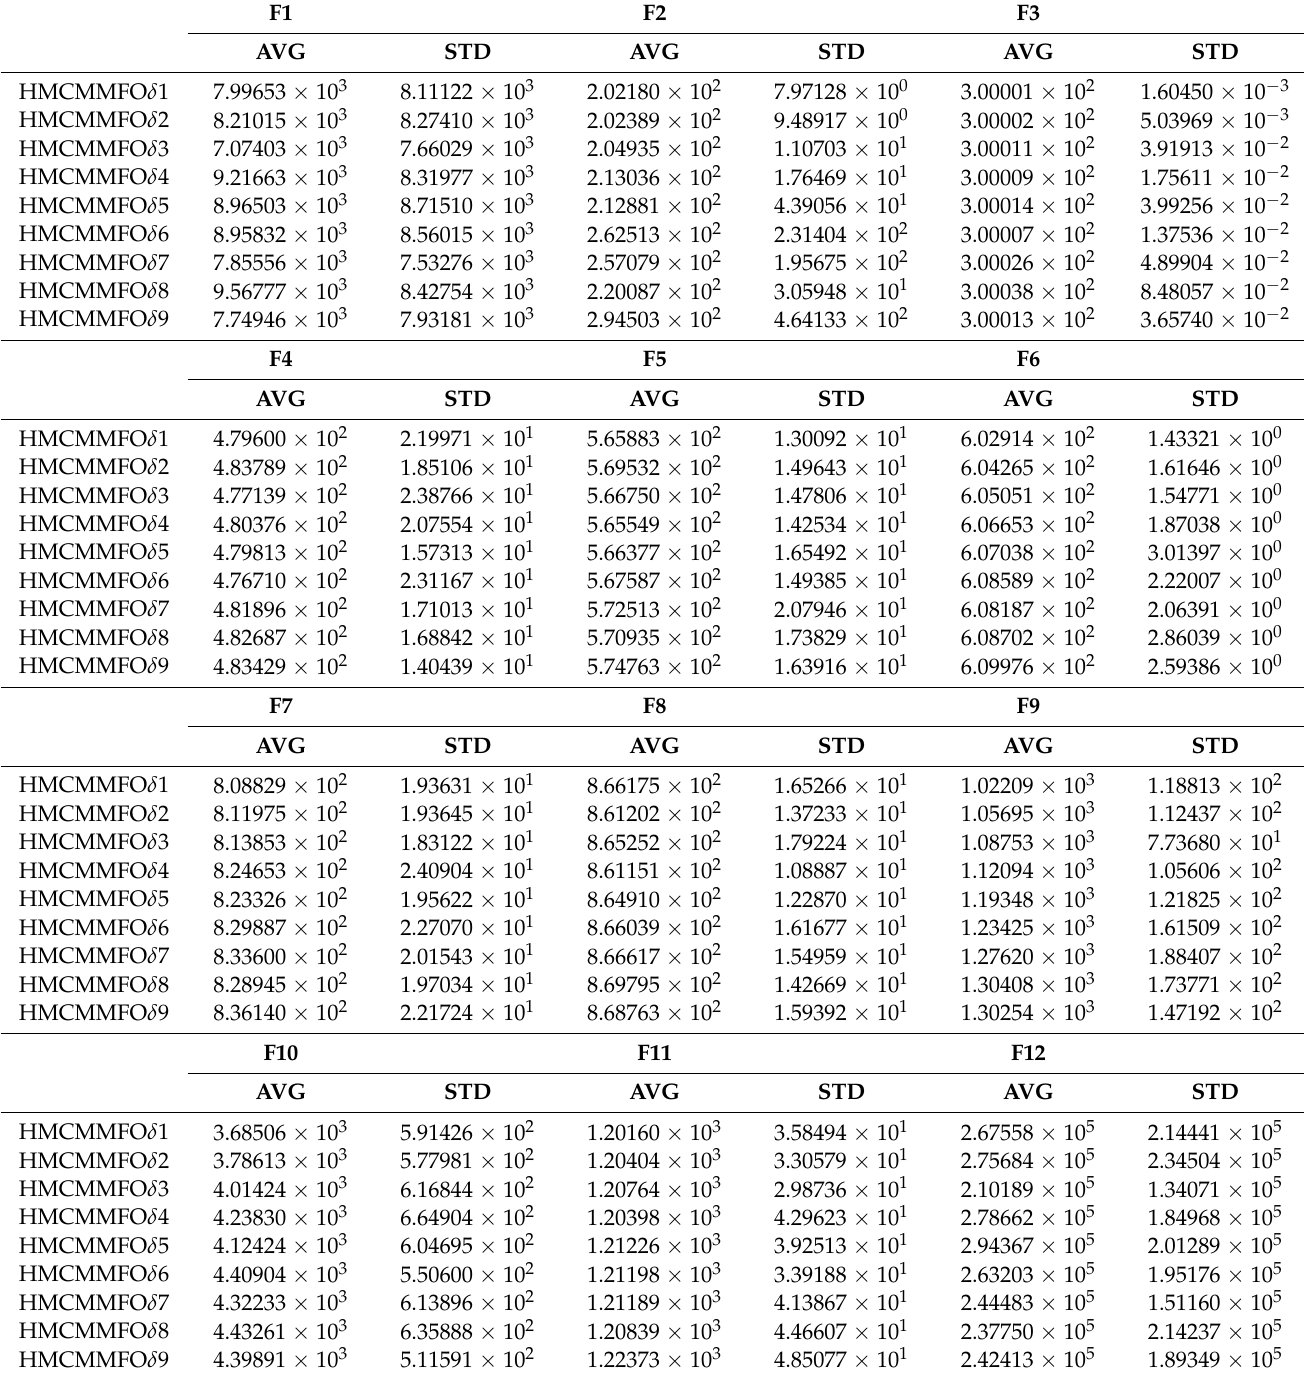
Table 2. Comparison of HMCMMFO results with different δ